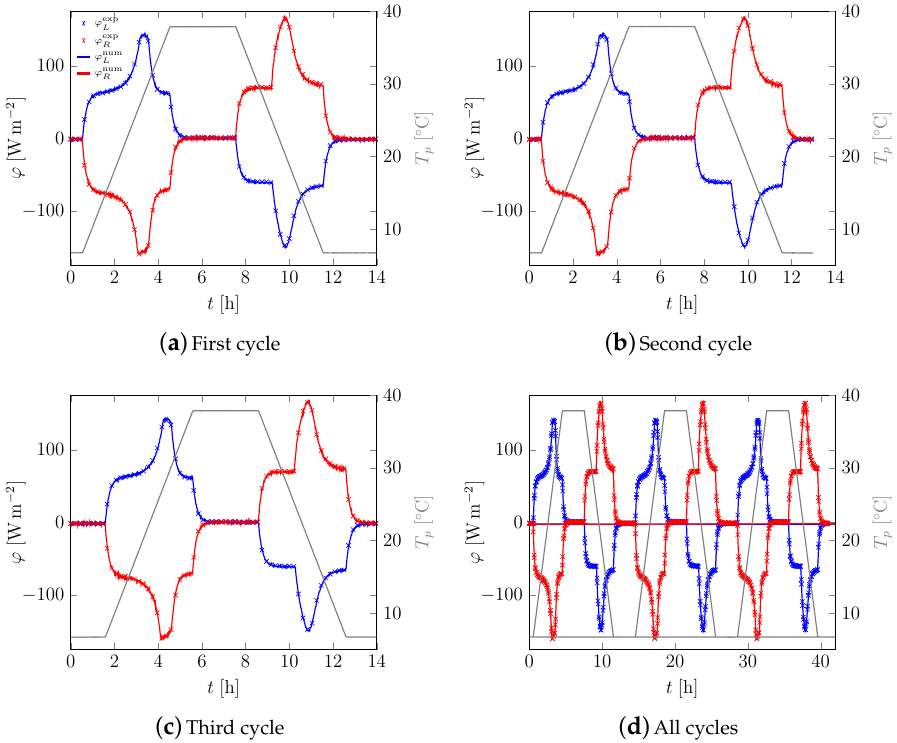
Figure A2. 12.4% w -PCM mortar: comparisons of the experimental fluxes with the numerical ones after identification for the 4h heating/cooling ramp experiment.